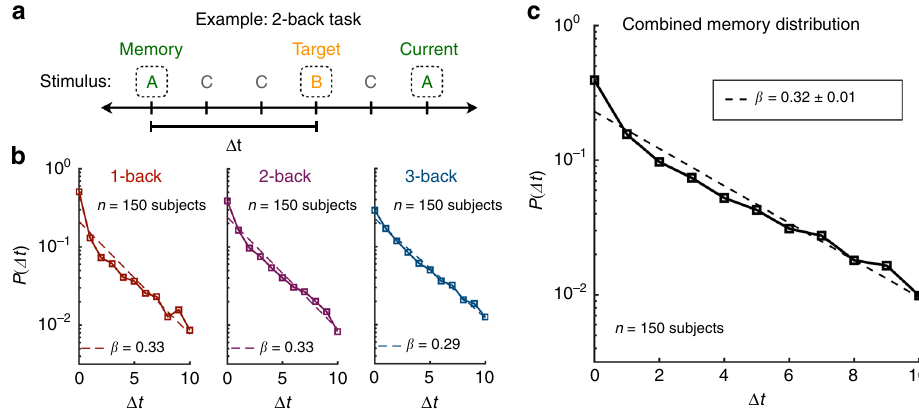
Fig. 5 Measuring the memory distribution in an n -back experiment. a Example of the 2-back memory task. Subjects view a sequence of stimuli (letters) and respond to each stimulus indicating whether it matches the target stimulus from two trials before. For each positive response that the current stimulus matches the target, we measure Δ t by calculating the number of trials between the last instance of the current stimulus and the target. b Histograms of Δ t (i.e., measurements of the memory distribution P ( Δ t )) across all subjects in the 1-, 2-, and 3-back tasks. Dashed lines indicate exponential fi ts to the observed distributions. The inverse temperature β is estimated for each task to be the negative slope of the exponential fi t. c Memory distribution aggregated across the three n -back tasks. Dashed line indicates an exponential fi t. We report a combined estimate of the inverse temperature β = 0.32 ± 0.01, where the standard deviation is estimated from 1000 bootstrap samples of the combined data. Measurements were on independent subjects. Source data are provided as a Source Data fi